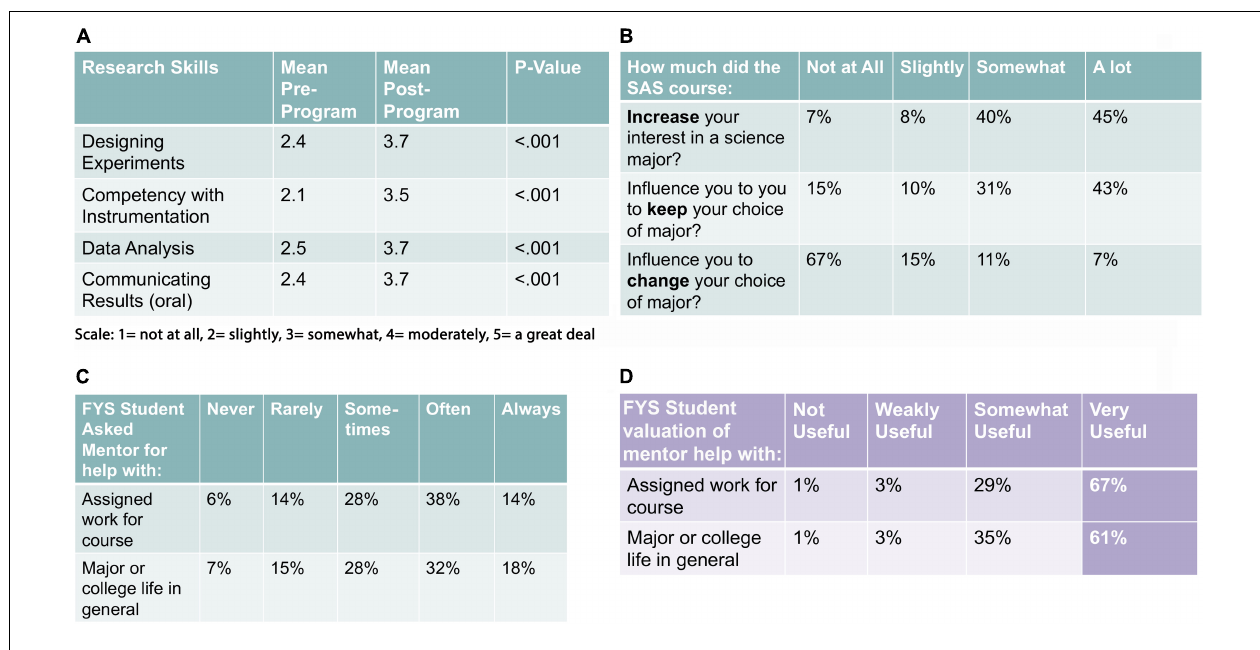
FIGURE 5 | Exemplar SAS course assessment data generated from student surveys and focus groups. Data in panel (A) represents a comparison of student assessments of efficacy in the four dimensions of research ability before and after program participation. These paired measures were analyzed by t -test with statistical significance assigned to p < 0.05. Panels (B–D) offer representative data from program surveys offered upon conclusion of the program. Panel (B) displays student reporting of program influence upon interest and retention in a science major. Panels (C) and (D) reveal frequency and valuation of student access to a faculty mentor. All of the data shown represents feedback from SAS students in the 2017 program cycle with 90% student participation in assessment ( n = 110). Pepperdine and Whitter college students are equally represented in these